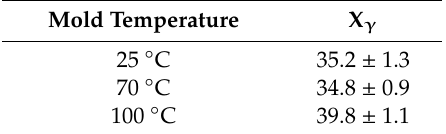
Table 2. Degree of crystallinity of 3%-MWCNT nanocomposites as a function of mold temperature. Mold temperature